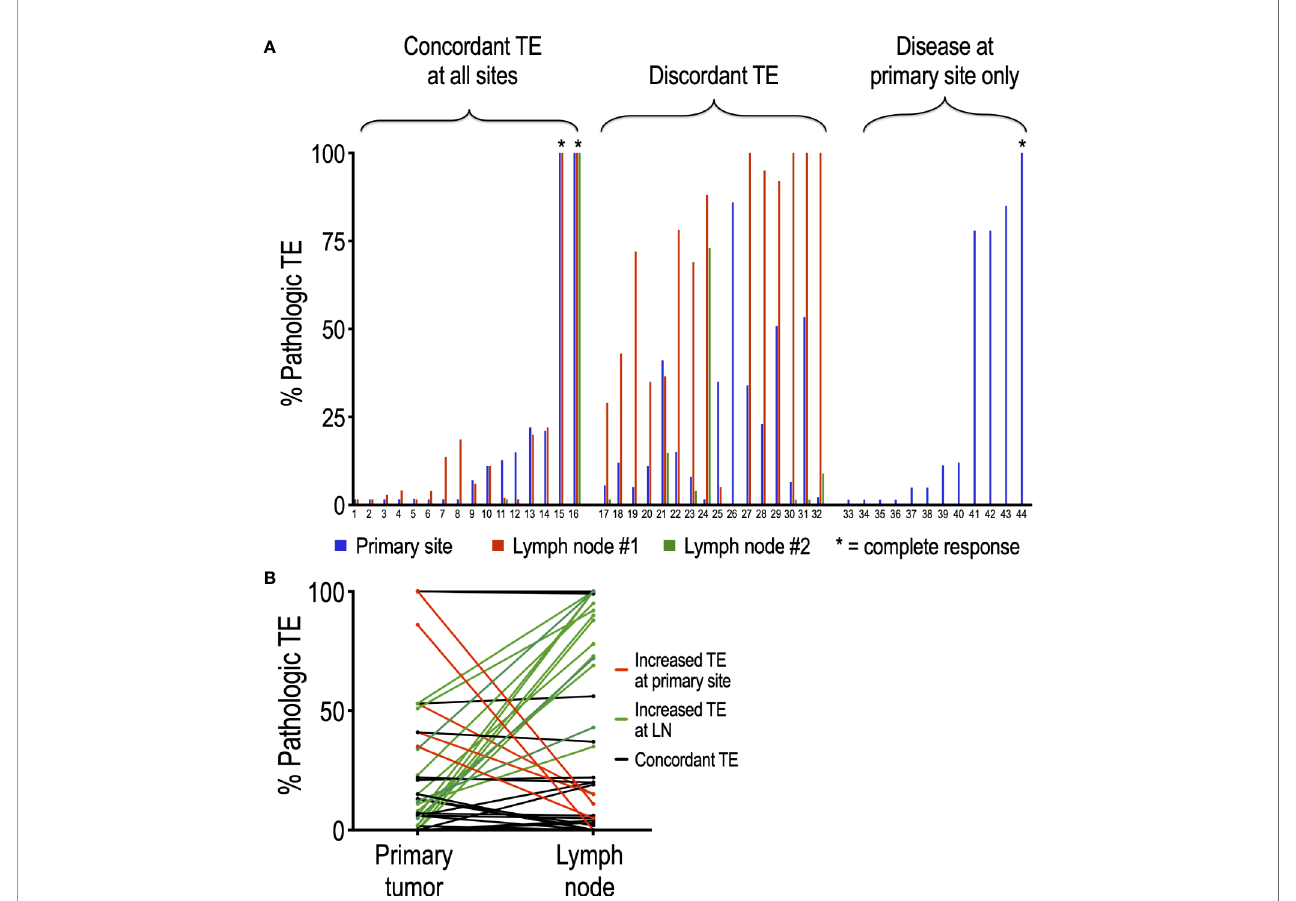
FIGURE 2 | Analysis of individual patients reveals frequent discordance between pathologic TE and primary site and lymph nodes. (A) Of the 44 patients analyzed, 32 had lymph nodes positive in addition to primary site; 16 of the 32 (50%) patients exhibited discordant PTE. (B) Discordant TE is driven primarily by an increased PTE at LN relative to primary site. Of the 40 nodes analyzed, only 5 (12.5%) (red lines) had higher PTE than their primary site; conversely, 14 (35%) (green lines) nodes had higher PTE than their matched primary site. Nodes with concordant PTE at primary site are depicted in